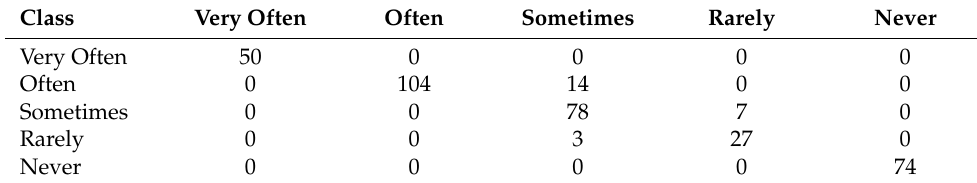
Table 6. Confusion matrix for naïve